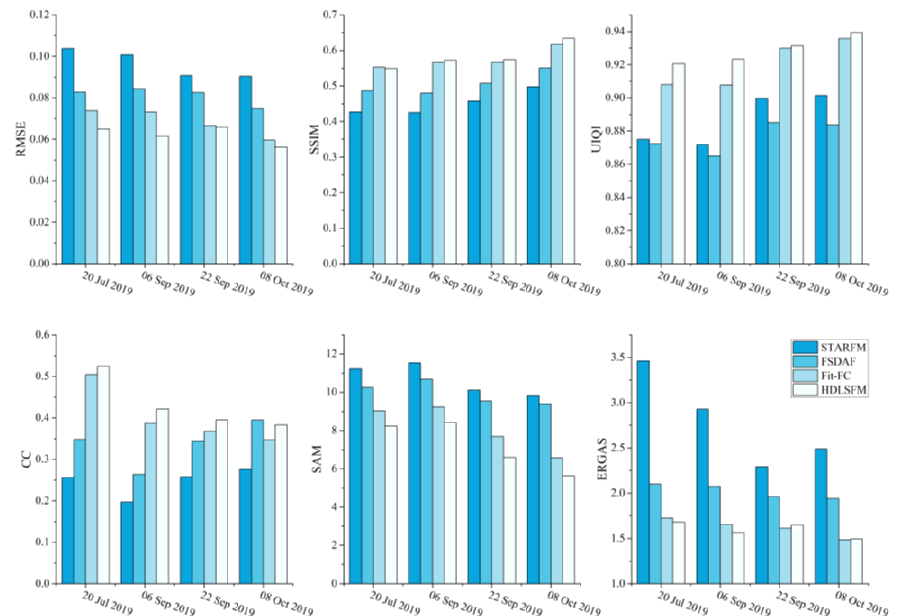
Figure 12. Prediction results of different STF methods of the southwest of Kansas State (SWK) site.